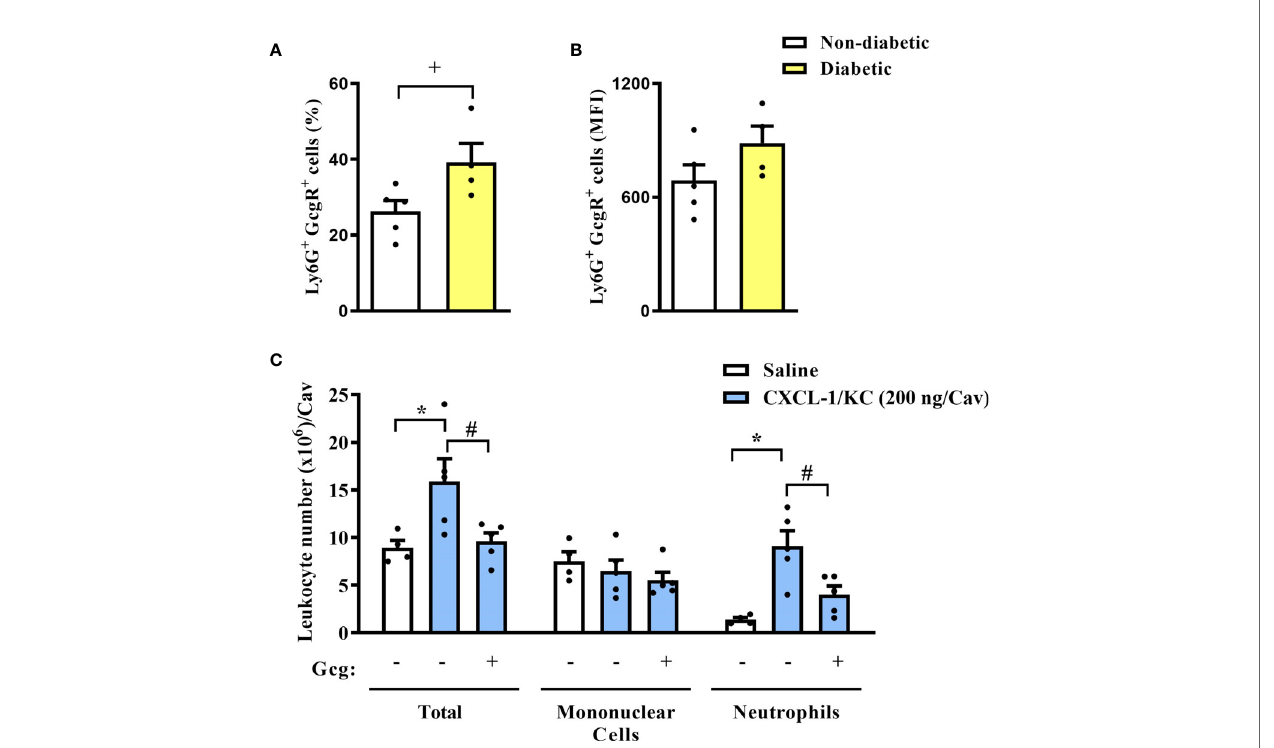
FIGURE 3 | Diabetes induces an increase in the neutrophils GcgR + proportions, and glucagon inhibits CXCL1/KC-induced neutrophil migration to the peritoneal cavity in vivo . (A) Percentage of Ly6G + cells that express GcgR obtained from the blood of non-diabetic and diabetic mice. (B) MFI of GcgR on Ly6G + cells from the blood of non-diabetic and diabetic mice. For (A, B) , blood neutrophils from 5 non-diabetic and 4 diabetic male mice were obtained. (C) Analysis of total and differential leukocytes in the peritoneal cavity of mice 3h after challenge with CXCL1/KC. Each sample value was obtained in blinded and randomized measurements. Glucagon (1 µg/kg) was injected i.p. 1h before challenging with the chemokine. Each value represents the mean ± S.E.M. The statistical analysis was performed by one-way ANOVA, followed by Newman – Keuls – Student ’ s t-test. Results are representative of one individual assay. + P < 0.05 compared to non-diabetic animals. * P < 0.05 compared to saline-challenged mice. # P < 0.05 compared to CXCL1/KC-challenged mice. Gcg,